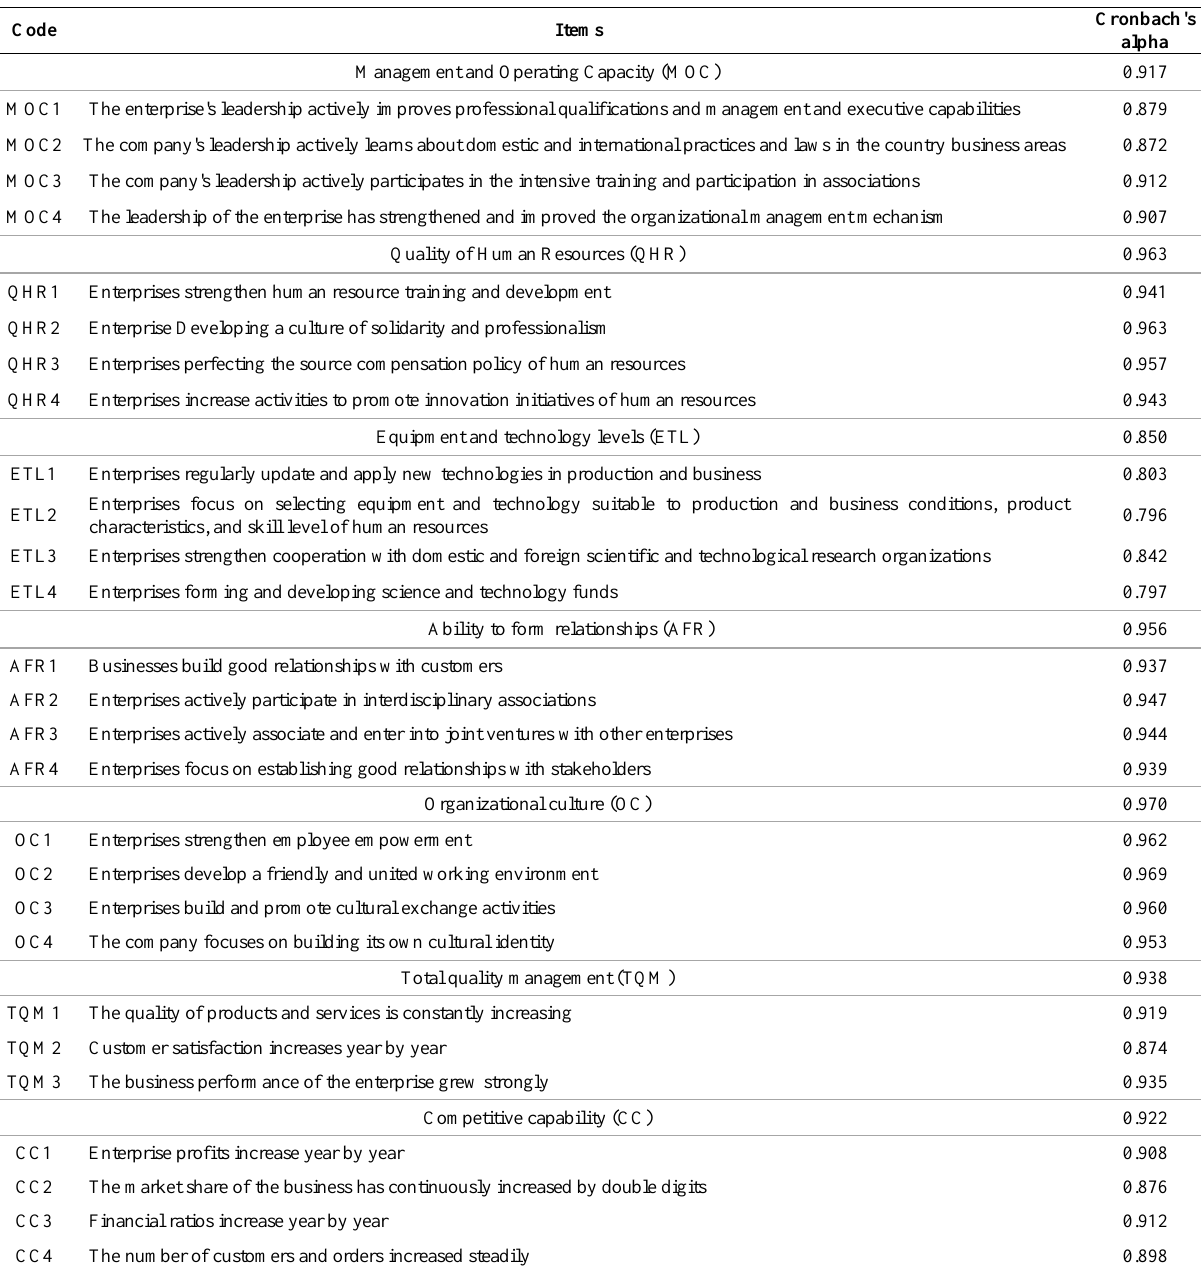
Table 2. Testing of Cronbach's alpha for five factors affecting total quality management and competitive